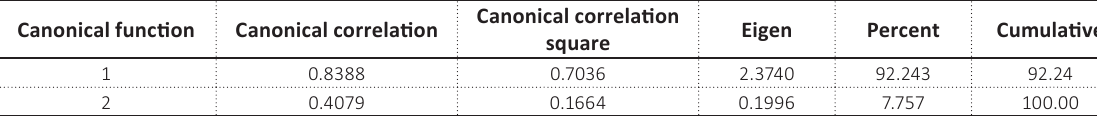
Table 6. Canonical correlation (the services sector) Canonical function